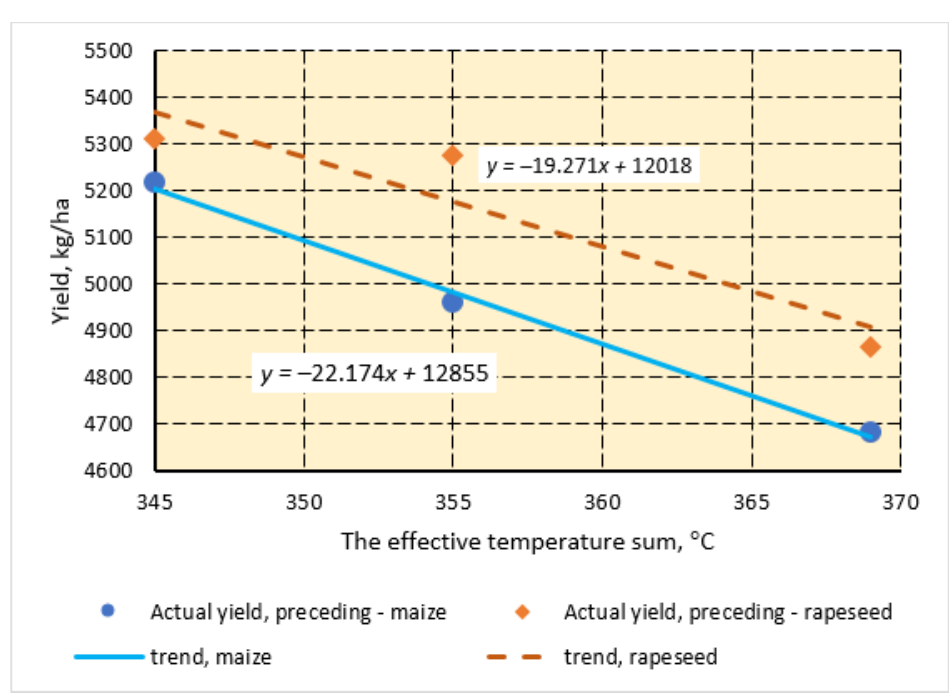
Figure 2. Yield versus the effective temperature sum of the autumn vegetation .